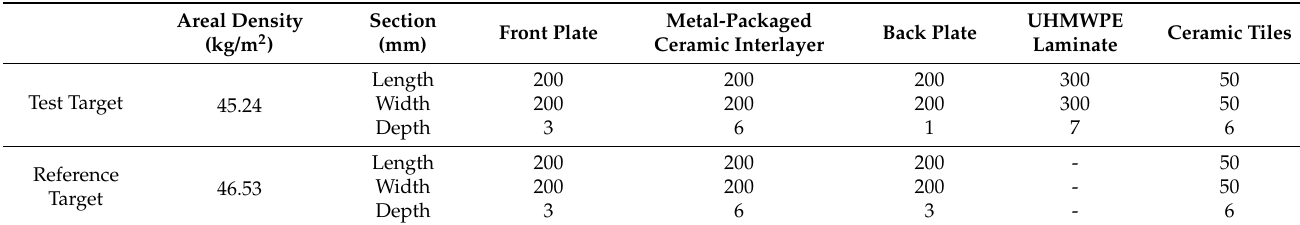
Table 1. The dimensions of the individual parts of the test and reference targets.